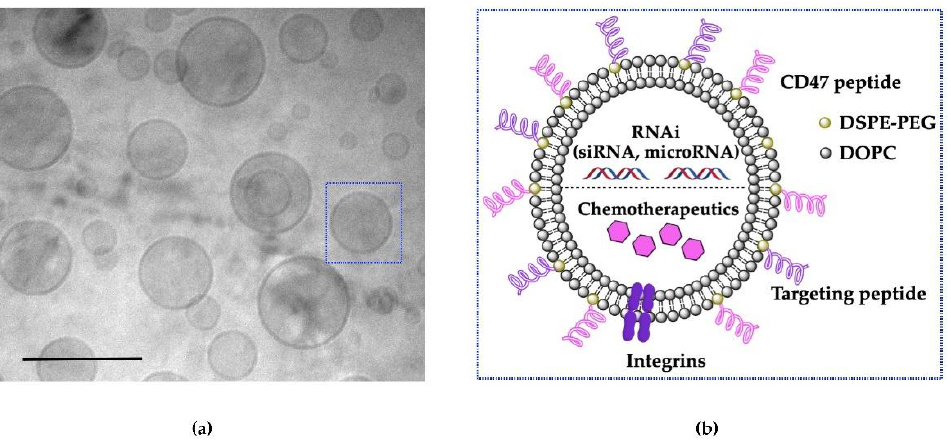
Figure 2. Engineered synthetic EV-mimetic morphology. ( a ) Cryo-TEM image of engineered synthetic EV-mimetic inspired by natural EVs lipid composition for therapeutic delivery of small molecules, proteins, drugs. Scale bar 200 nm. ( b ) Schematic illustration of surface functionalization of synthetic EV-mimetics by insertion of a conjugated lipid DSPE-PEG-CD47 and encapsulation siRNAs and chemotherapeutics for enhanced therapeutic effects.